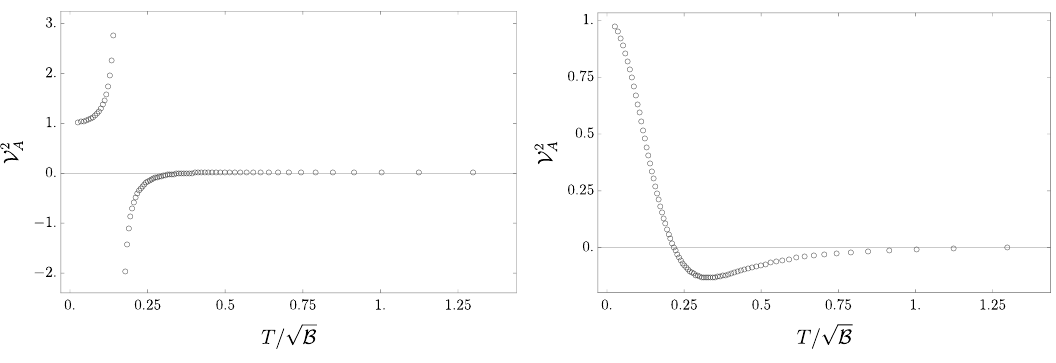
Figure 13 . The (cid:18) -independent factor V A of the Alfv(cid:19)en wave speed plotted for the renormalised e 2 ! 1 (left) from eq. (4.17) and for e 2 (cid:24) ln B (right) from eq. r